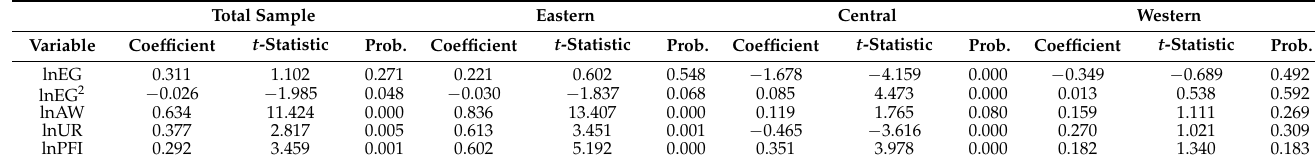
Table 4. Regional long-term regression results used panel FMOLS